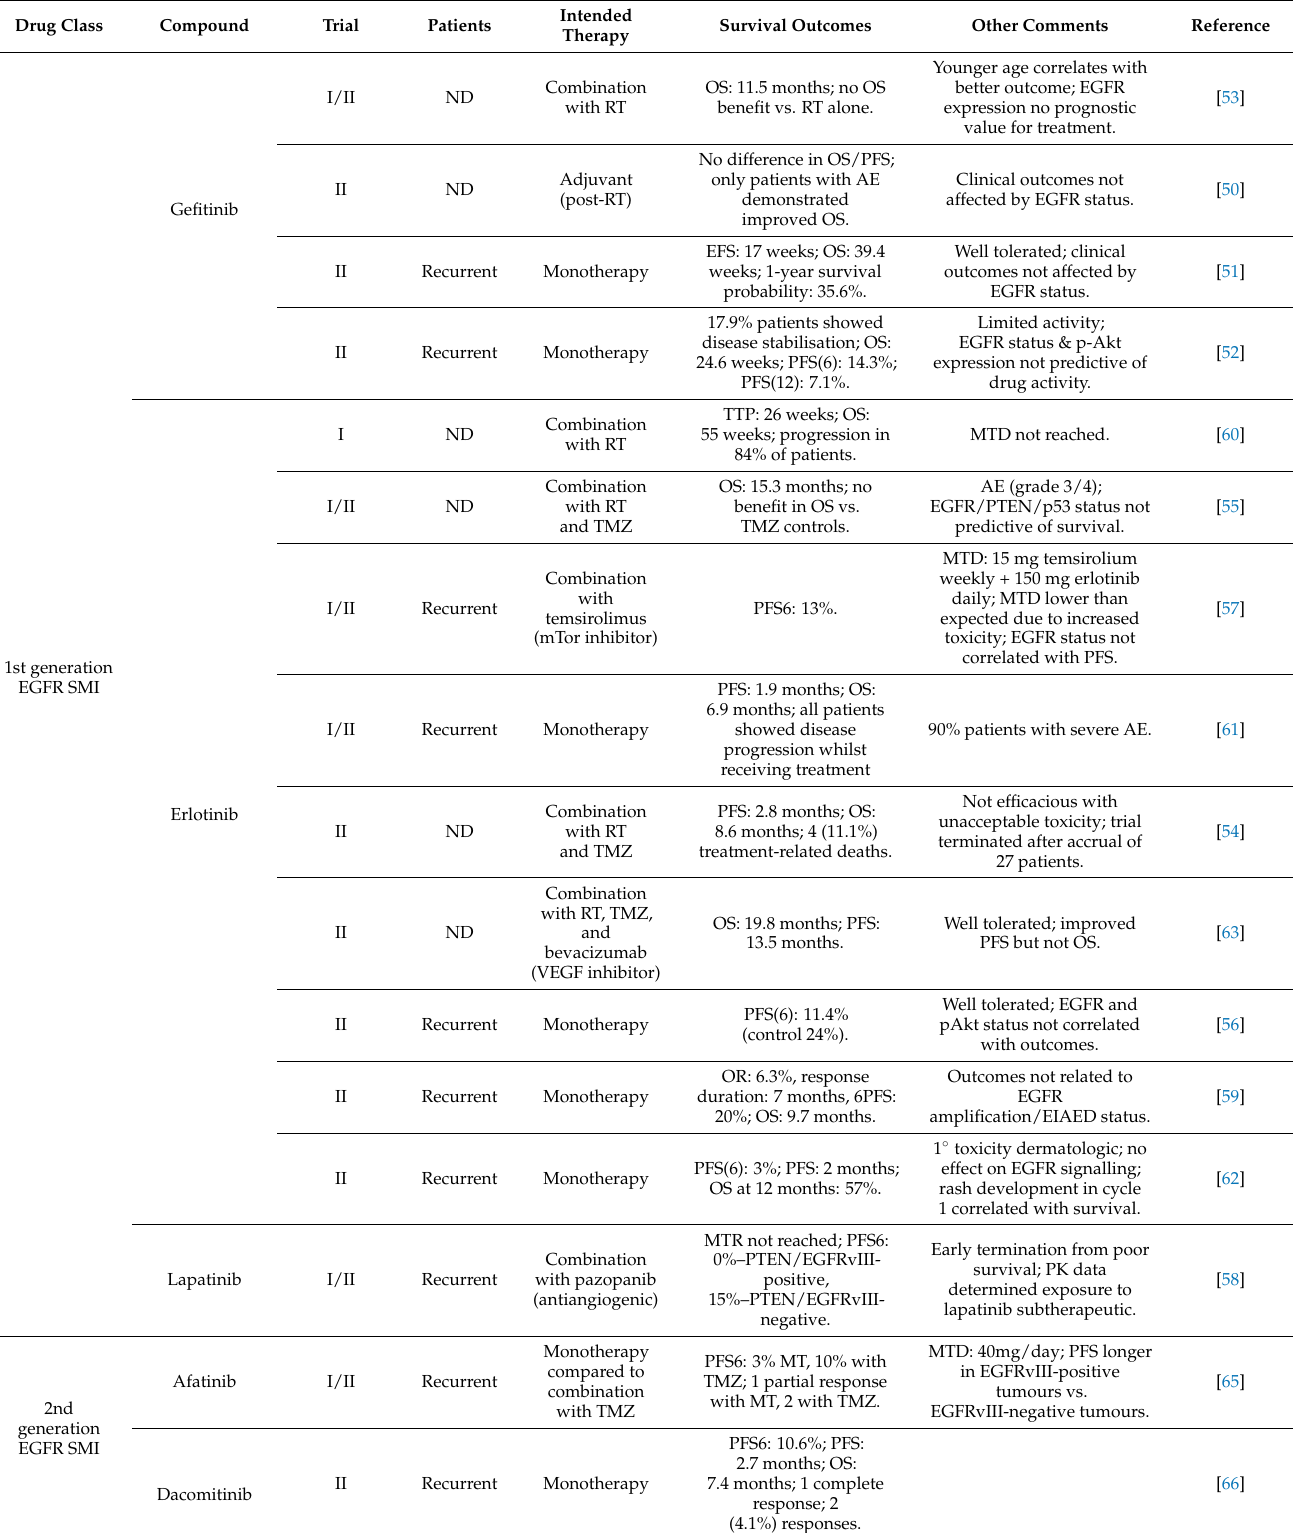
Table 1. EGFR-targeted therapy in GBM clinical